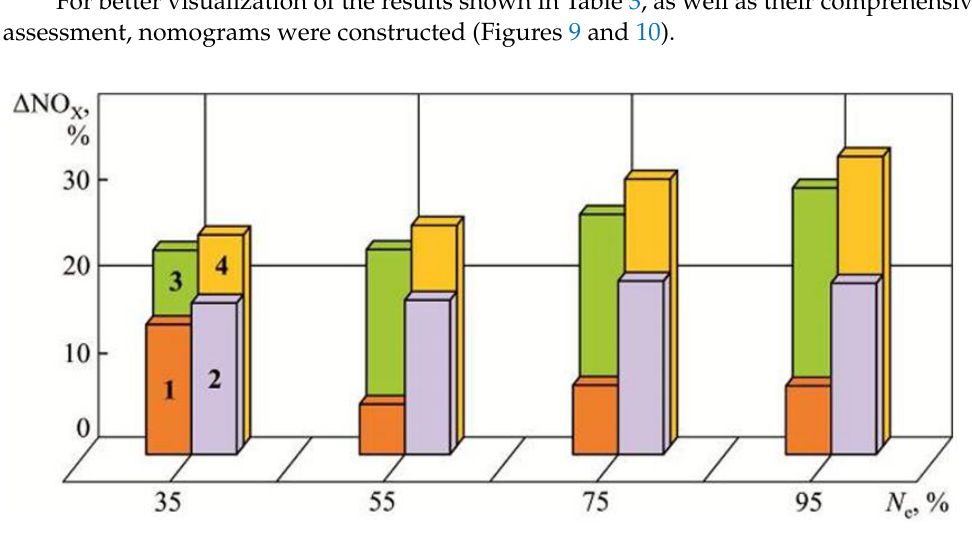
Figure 10. Relative increase in the specific fuel consumption be at different loads of a 16V32 STX- MAN marine diesel when using the EGR system: 1 — δ EGR = 3%; 2 — δ EGR = 9%; 3 — δ EGR = 15%; 4 — δ EGR = 21%. The data presented confirm the thesis about the need for a comprehensive assessment of the environmental and economic performance of a diesel engine. When using the exhaust gas recirculation system, due to the deterioration of mixture formation, the delay period for self-ignition of the fuel increases, and combustion is shifted to the expansion line, contributing to an increase in the temperature of the exhaust gases. Exhaust gas temperature is an indicator, the control, and maximum permissible values of which are strictly regulated by the manufacturer ’ s instructions for the operation of marine diesel engines (for a 16V32 STX-MAN diesel engine, its maximum value should not exceed 500 °C). In this regard, during experimental studies (using the Unitor ProPower diagnostic system), this parameter was monitored. The results of measure- ments are given in Tables 4 and 5 and are displayed in Figures 11 – 14.